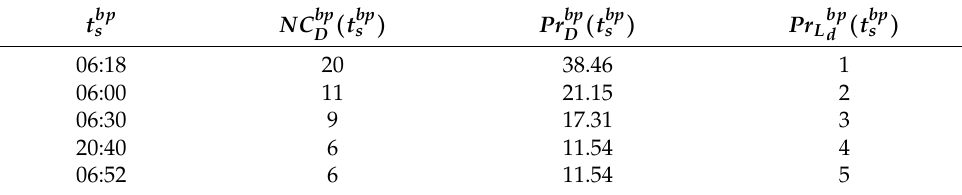
Table 11. Priority level values for t bp s for Scenario 2.